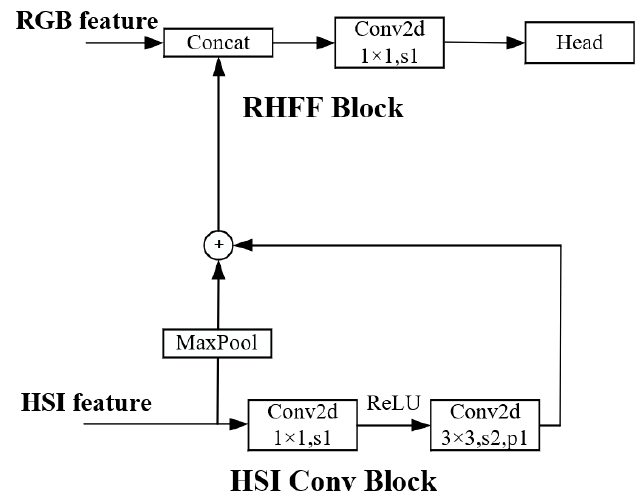
Figure 4. HSI Conv Block and RHFF Block.